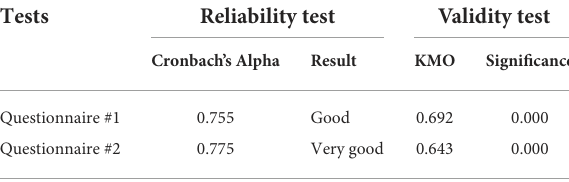
TABLE 1 Summary of test results for reliability and validity of the questionnaire.